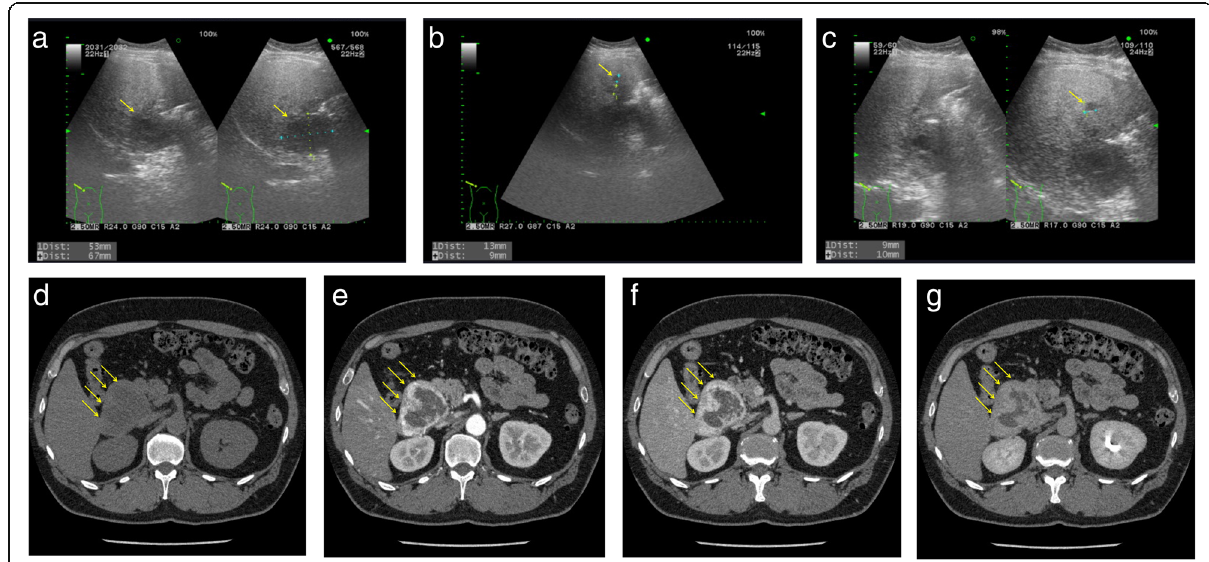
Fig. 1 Abdominal ultrasonography (US) and contrast-enhanced abdominal computed tomography (CT). US images showing well-defined, hypoechoic masses in segments 1 ( a ), 2 ( b ), and 6 ( c ). Pre-contrast CT scan image showing a low-density 65-mm mass with an irregular margin in the caudate region ( d ). Contrast-enhanced CT scans images revealing peripheral early ring enhancement in the arterial phase and internal heterogeneous enhancement in the delayed phase ( e – g